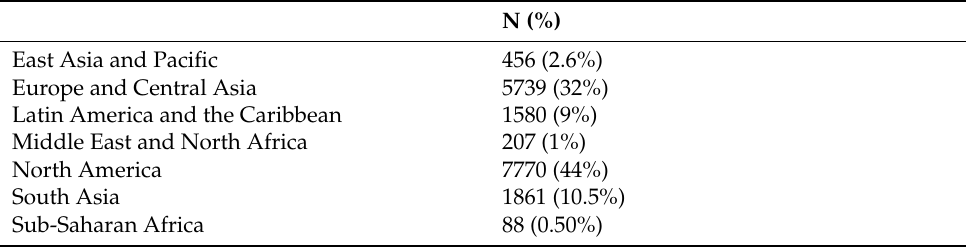
Table A1. CLIC Sample by WHO Regions (n =